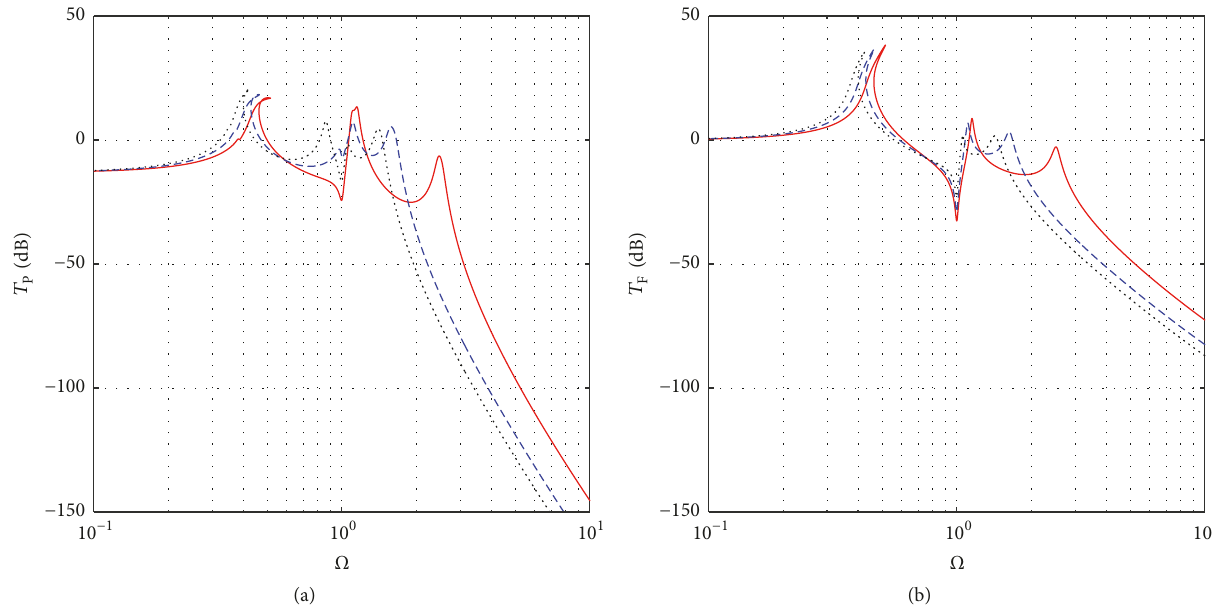
Figure 5: Power transmissibility (a) and force transmissibility (b) of the two-stage HSLDS system with different mass ratio 𝜇 1 . The parameters are 𝜇 2 = 1 , 𝜆 1 = √5 , 𝜆 2 = 1 , 𝜇 = 0.2 ; blue dashed line, 𝜇 1